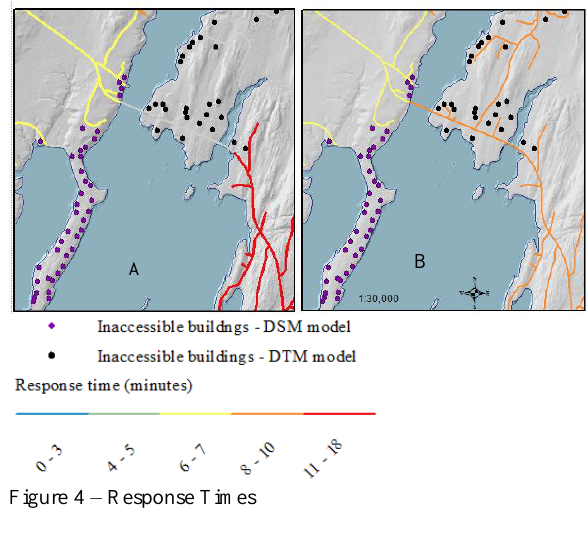
Figure 4 – Response Times